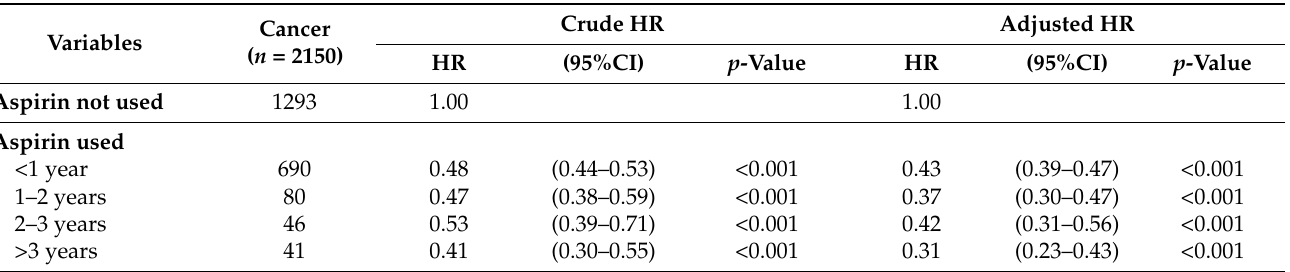
Figure 2. Kaplan–Meier curves showing the cumulative incidence of primary cancer in aspirin users and aspirin nonusers in this study. Table 2. The dose responses to aspirin among the ischemic cardiovascular and ischemic cerebrovas- cular disease survivors in our